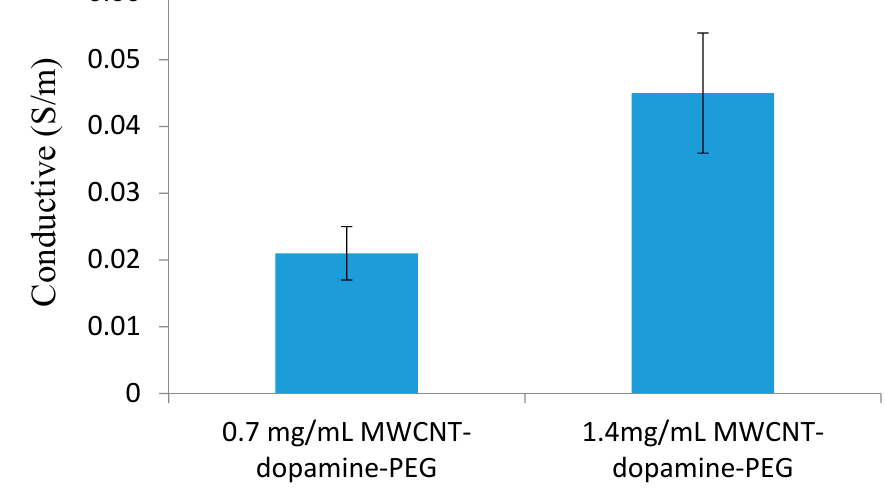
Figure 7. Electric conductivity of 0.7 mg/mL and 1.4 mg/mL of MWCNT-dopamine-PEG gels.